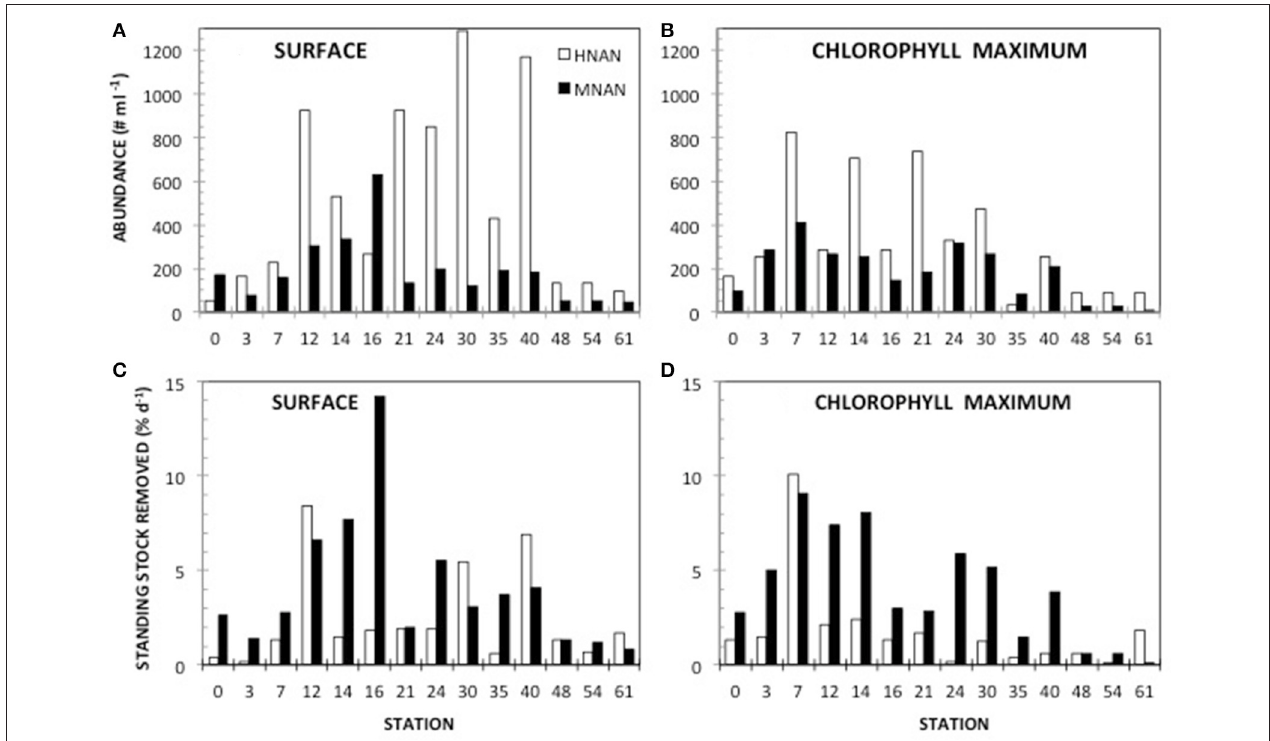
FIGURE 2 | Mixotroph abunance and grazing impact. Abundance of mixotrophic nanoflagellates (MNAN) and heterotrophic nanoflagellates (HNAN) determined by microscopy at (A) the surface and (B) the deep chlorophyll maximum. Amount of bacteria removed by MNAN or HNAN grazing at (C) the surface and (D) the deep chlorophyll maximum.